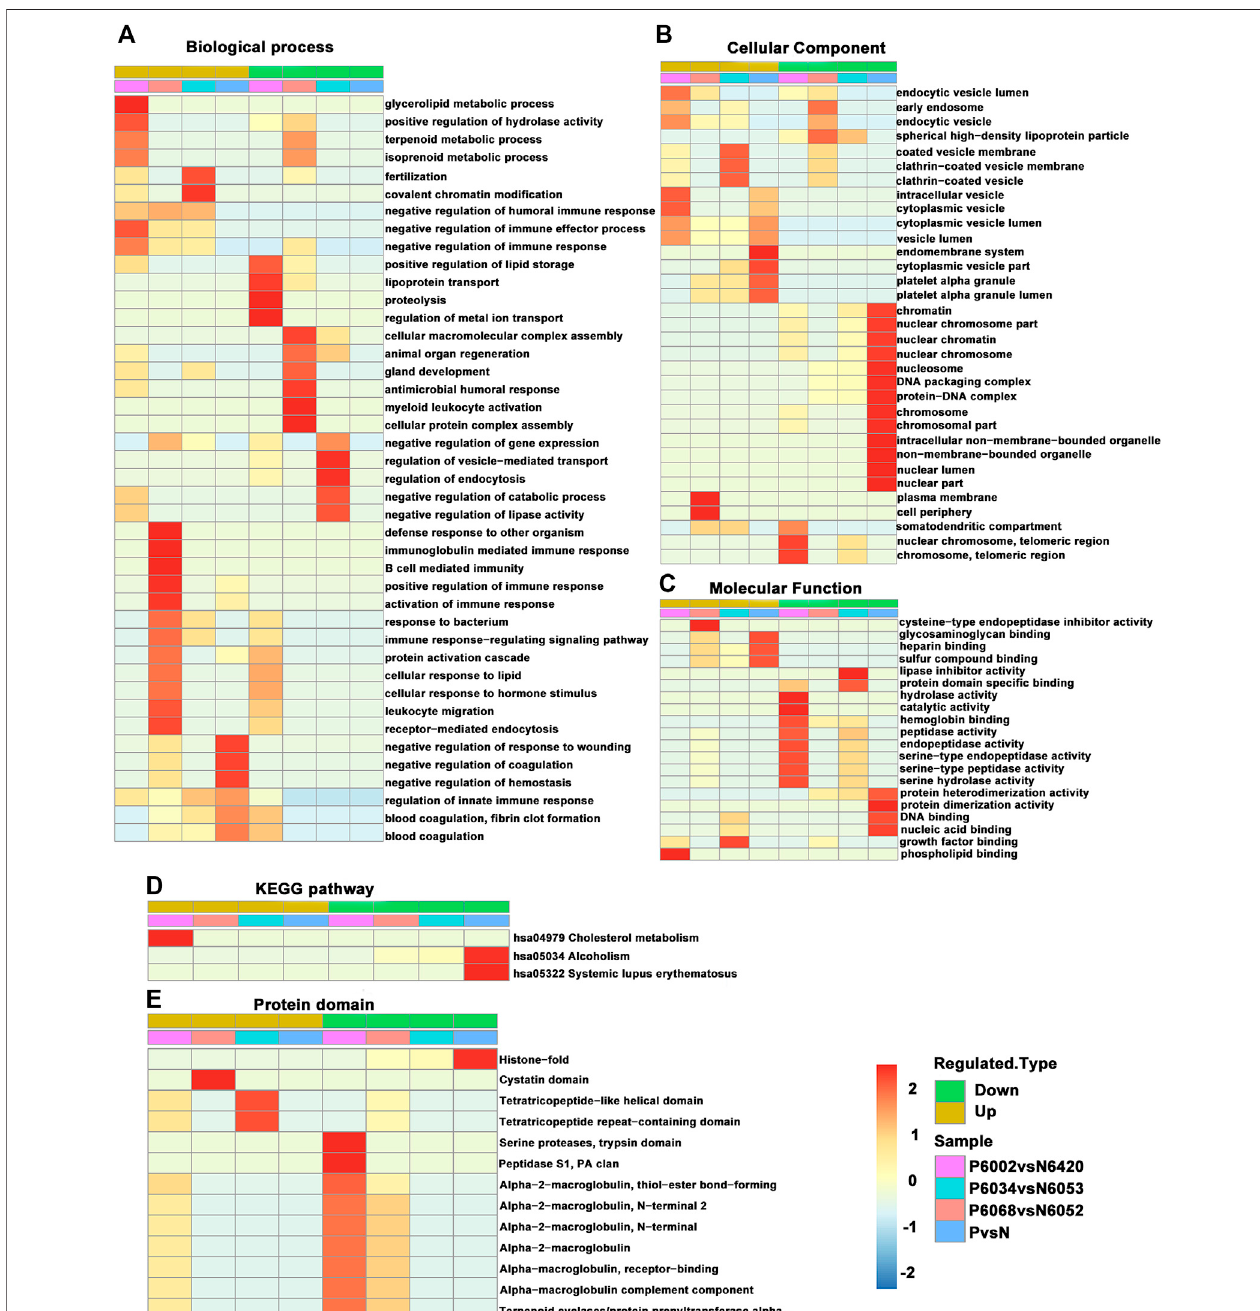
FIGURE 6 | A comprehensive heat map for cluster analysis of the enrichment patterns of GO functional categories, KEGG pathways, and protein domains. (A) Biological process. (B) Cellular component. (C) Molecular function. (D) KEGG pathway. (E) Protein domain.